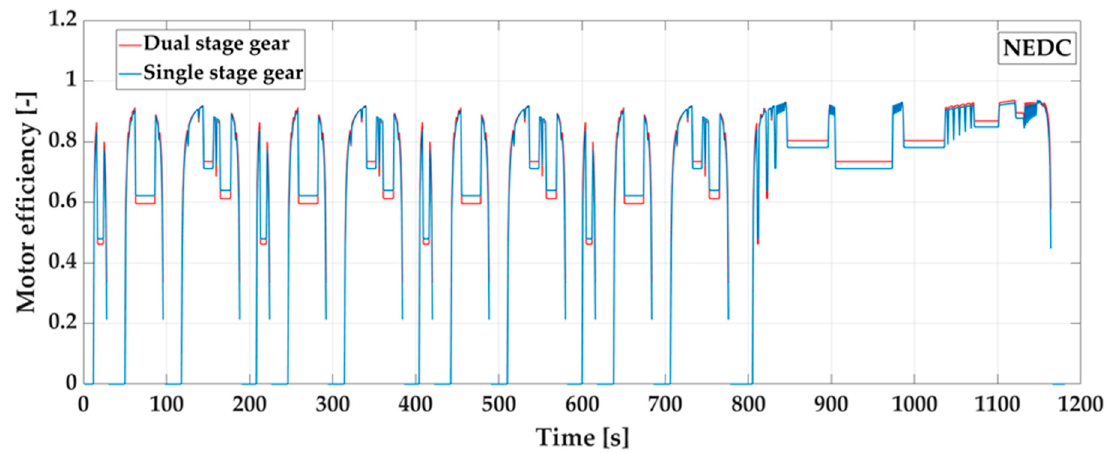
Figure 11. Motor efficiency vs. time for NEDC.